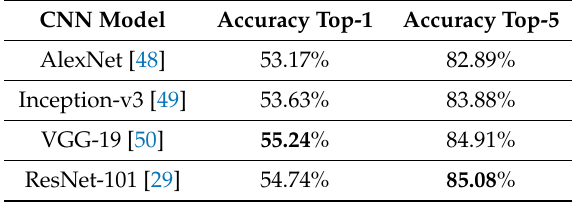
Table 7. Comparative experimental results of scene understanding algorithms on datasetPlace365. (365 classes).